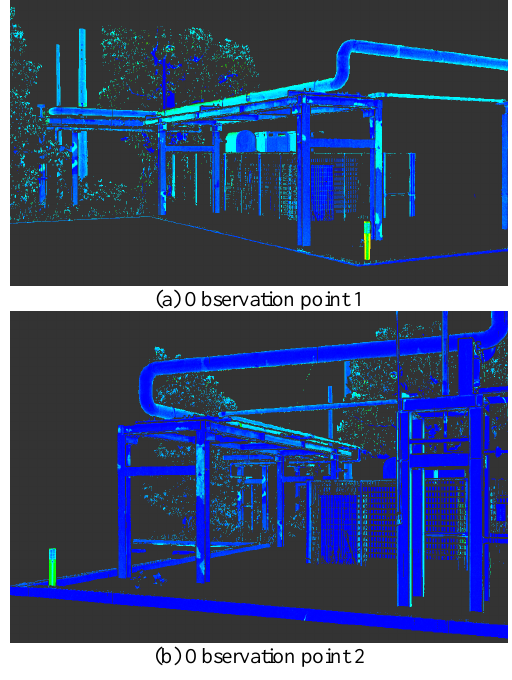
Figure 10. Intensity images for same target as section 4.2 captured from a different angle.